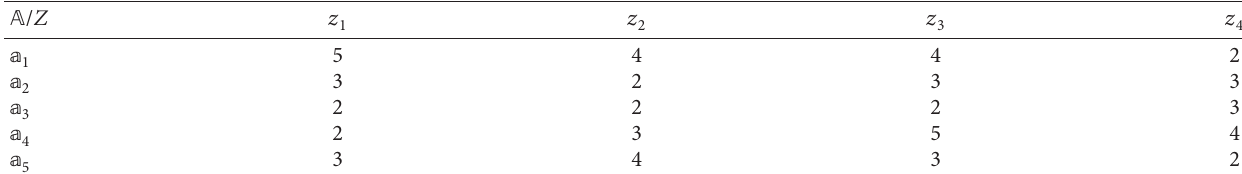
Table 21: Tabular representation of 6-soft set.